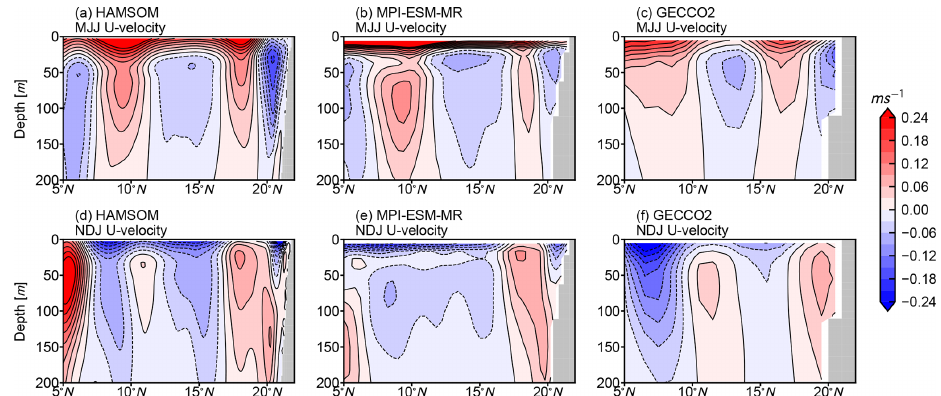
Figure 5. Depth–latitude section of climatological U velocity (averaged over 88 to 90 ◦ E) during MJJ (a, b, c) and NDJ (d, e, f) from HAMSOM, MPI-ESM-MR, and GECCO2, respectively. The contour intervals are 0.03ms − 1 .